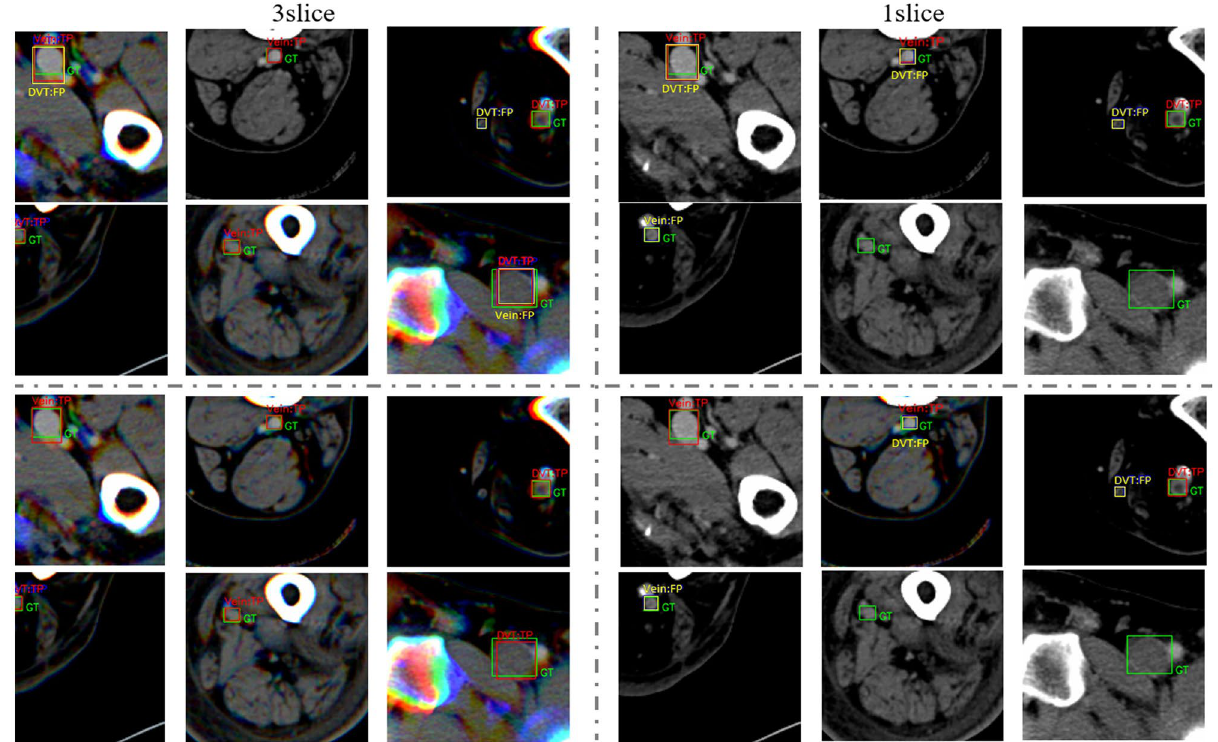
Figure 4. The example of results-image patches from model’s each backbone (ResNet50 and ResNet152) and each used data (3 slices and one slice). The red rectangle box means true positive result from the model. The green rectangle box is the ground truth, and the yellow rectangle box indicates a false positive result from the